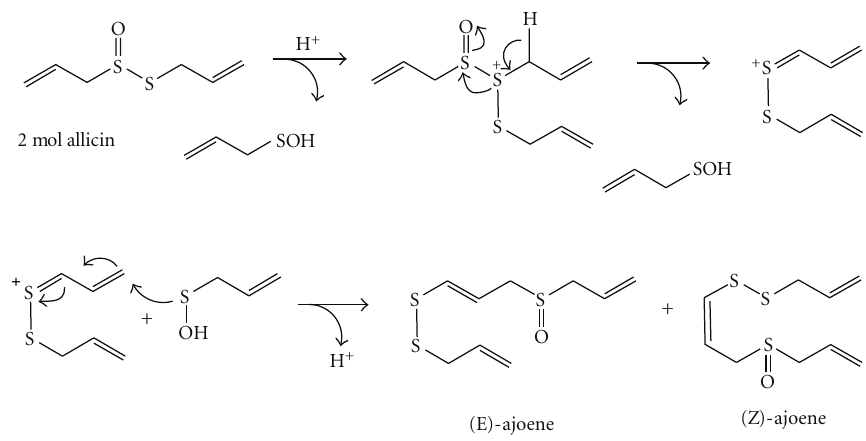
Scheme 1: Mechanism of allicin transformation to ajoenes [21].